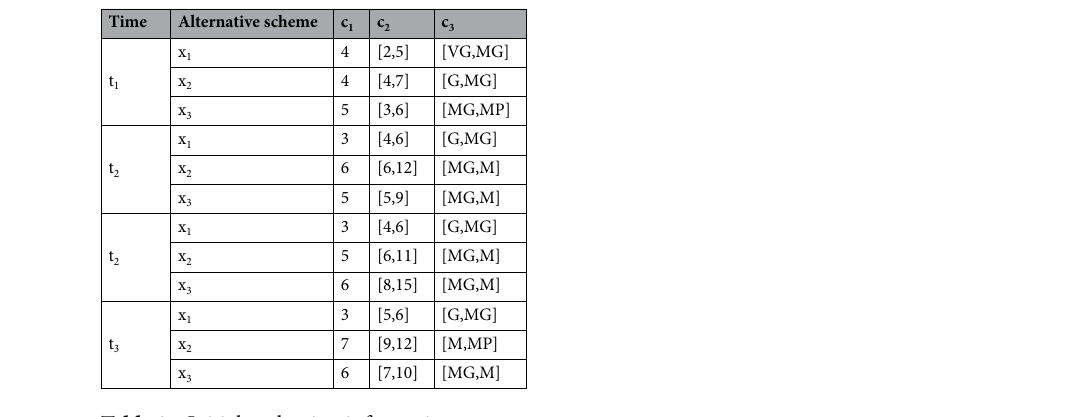
Table 2. Initial evaluation